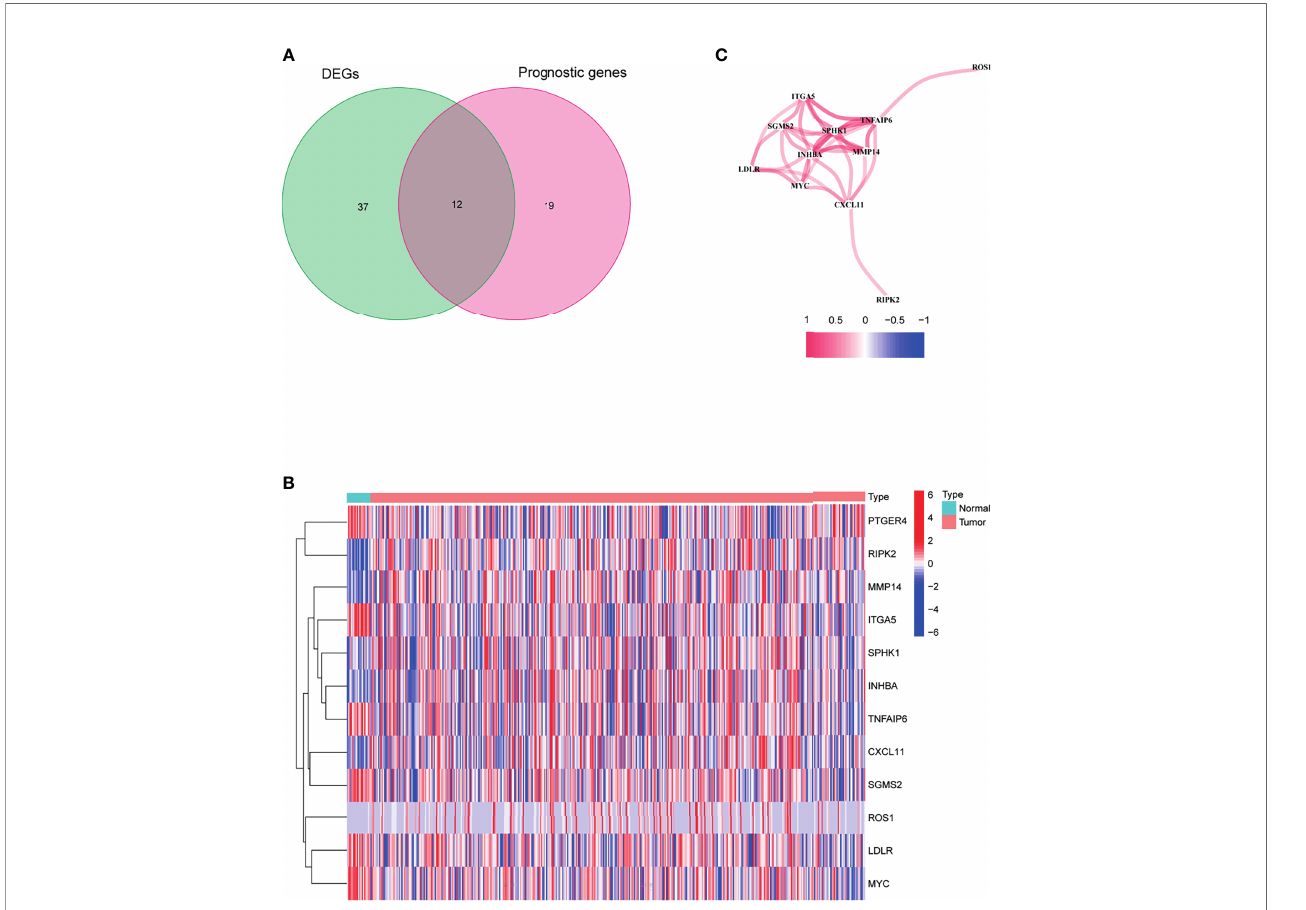
FIGURE 2 | Identi fi cation of the candidate in fl ammatory response-associated genes in the TCGA cohort. (A) Venn diagram to identify DEGs between BLCA tissues and adjacent normal tissues. (B) The 13 overlapping genes expression between BLCA tissues and adjacent normal tissues. (C) The correlation network of candidate